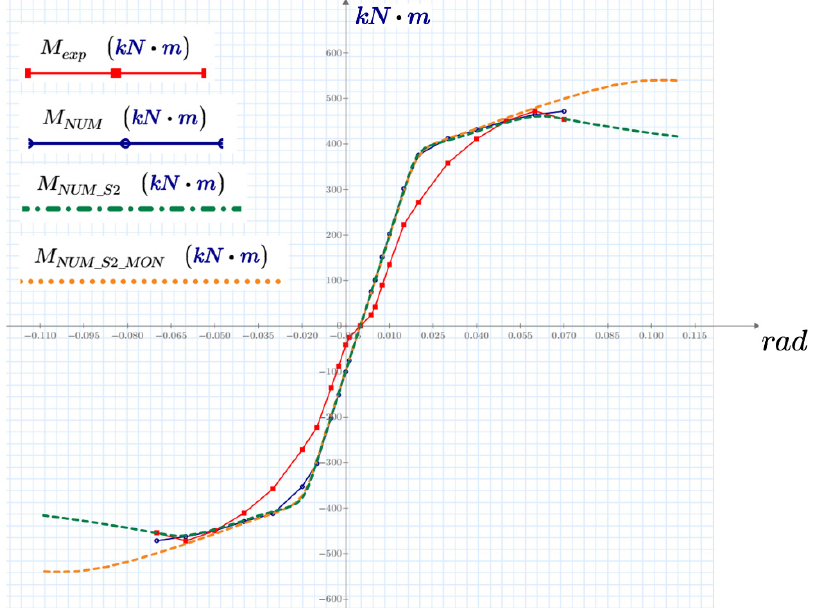
Figure 16. Comparison between the envelope curves obtained in the experiments ( M exp ), the original numerical model ( M NUM ) and the numerical model after the second simplification ( M NUM_S2 ). For the numerical model obtained after the second simplification, the analysis was raised to a rotation level of 0.11 radians to consider the resistance degradation trend due to local buckling in the beam flanges. The green curve in Figure 16 describes this behavior, which corresponds to what is expected once the buckling effect occurs. The local buckling failure is shown in Figure 17, demonstrating that the results provide a good approximation to the actual behavior.